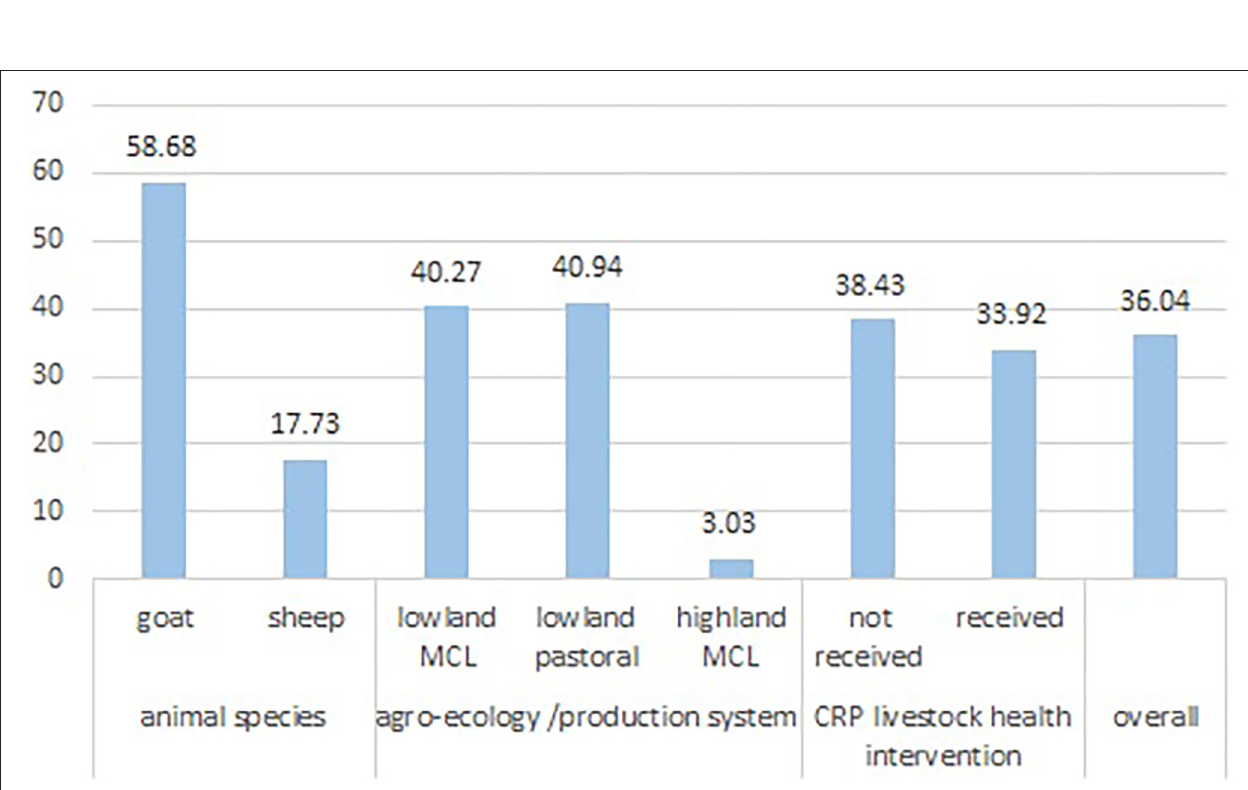
Frontiers in Veterinary Science |